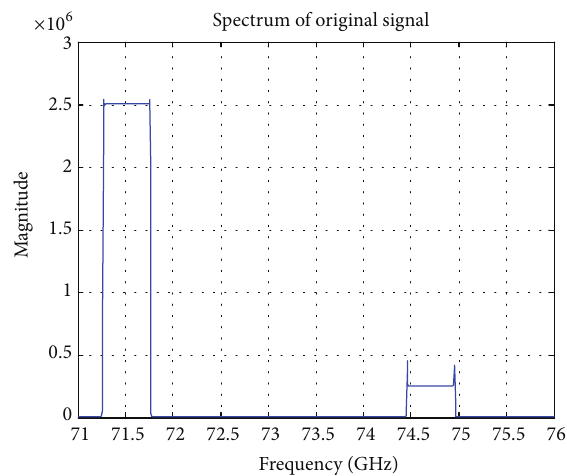
Figure 7: Spectrum of original multiband signal.